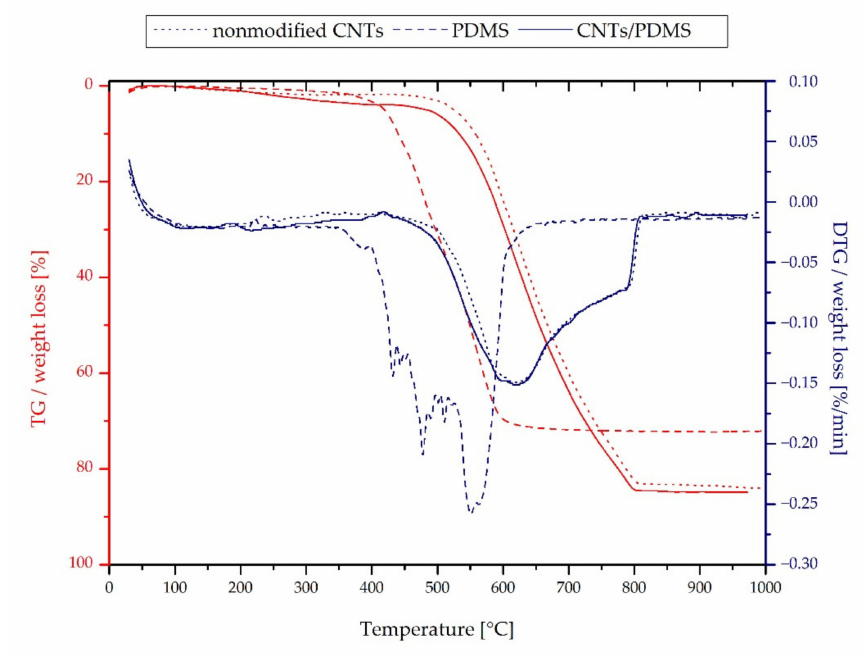
Figure 3. Thermal analysis of the MWCNTs, PDMS, and silica–MWCNTs/PDMS